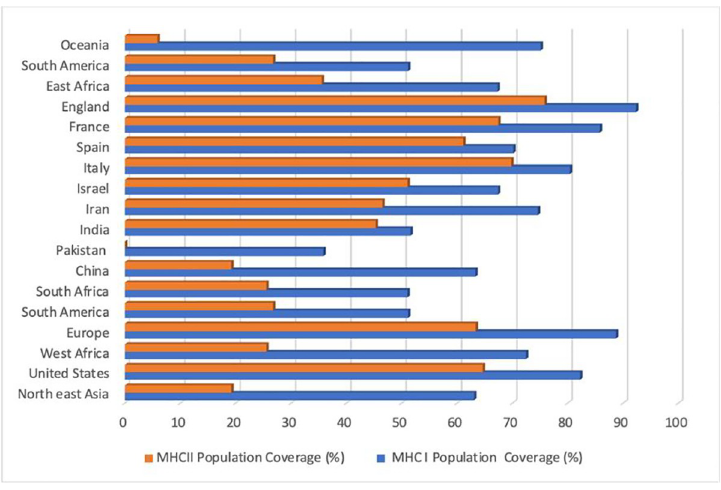
Fig 2. Selected continents and countries’ coverage of the MHC class I and II T cell